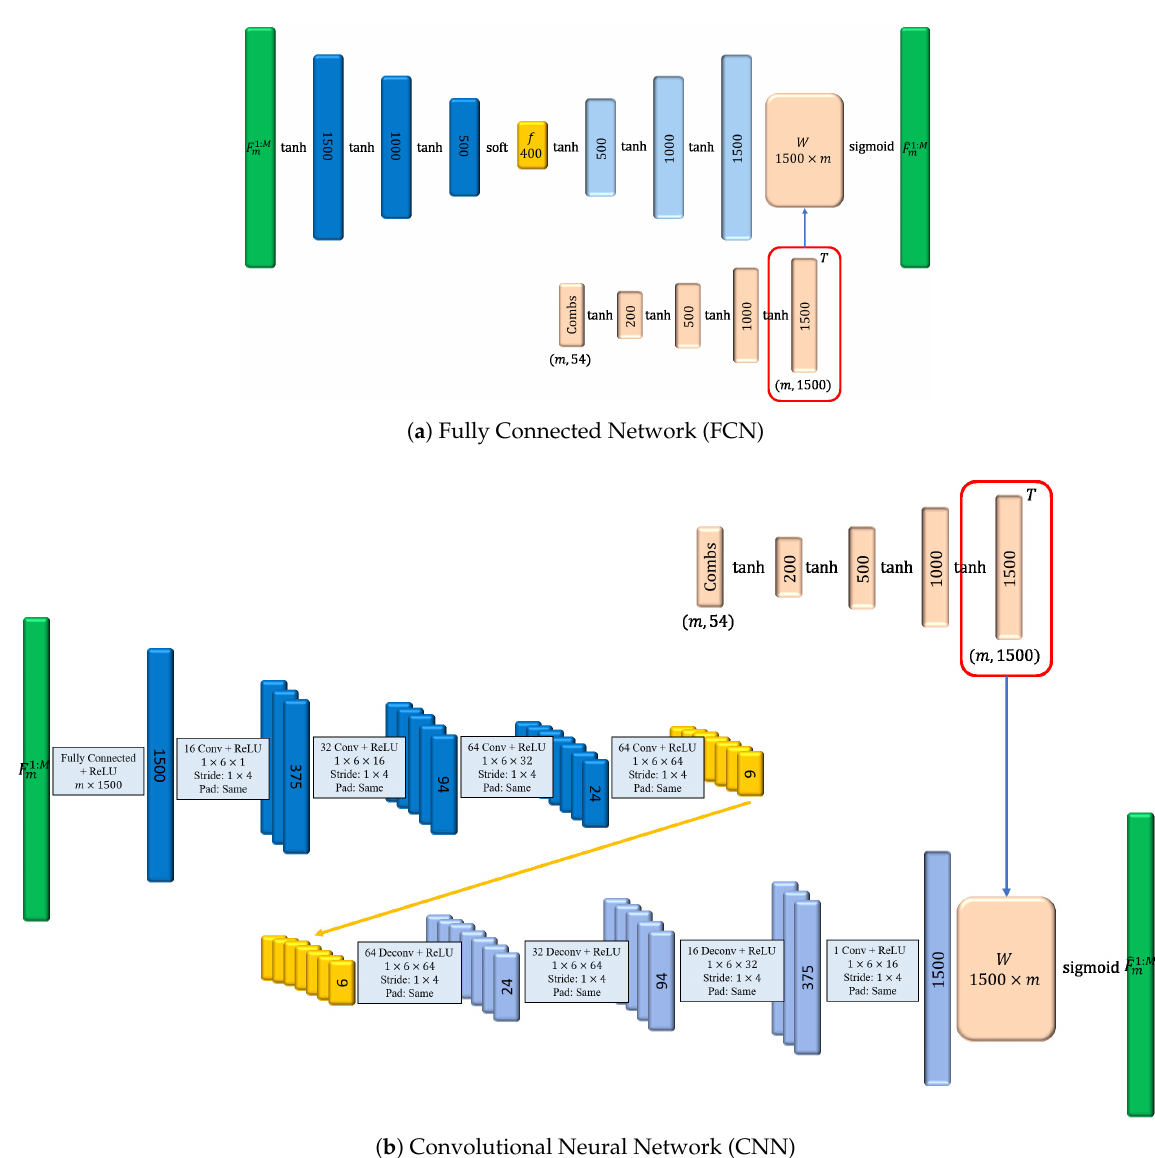
Figure 9. The frameworks of the transformation learning. This stage includes an autoencoder, weighting networks ( W ), and combinational